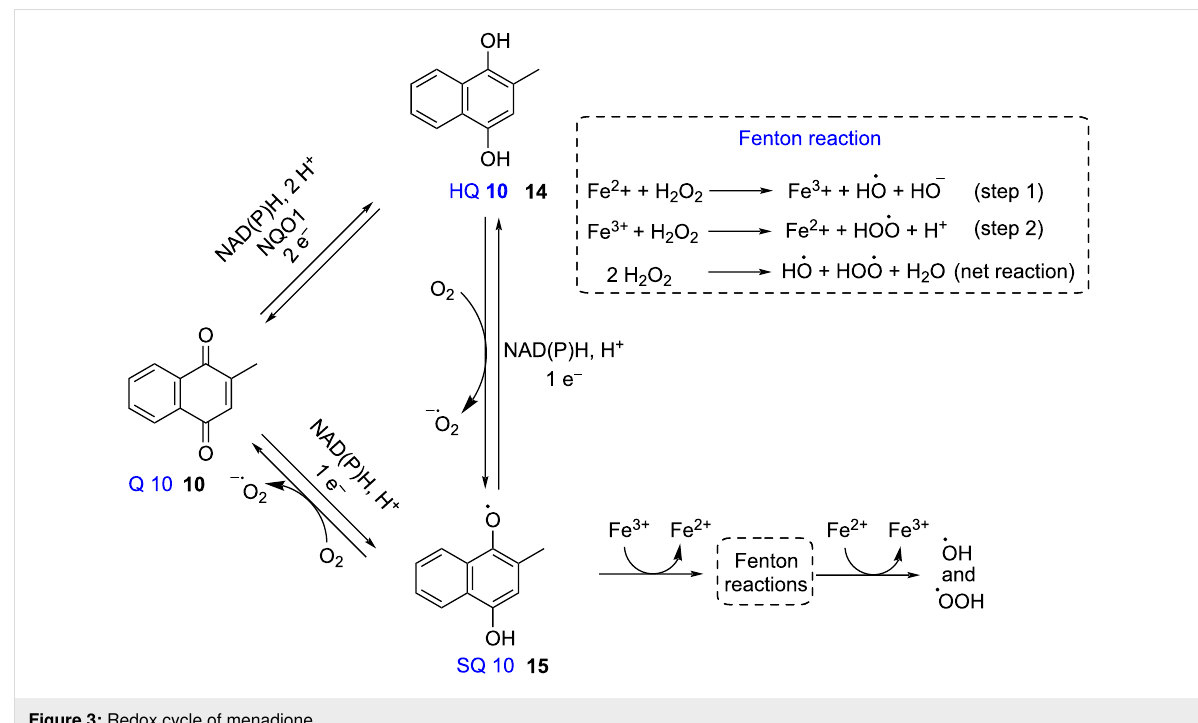
Figure 3: Redox cycle of